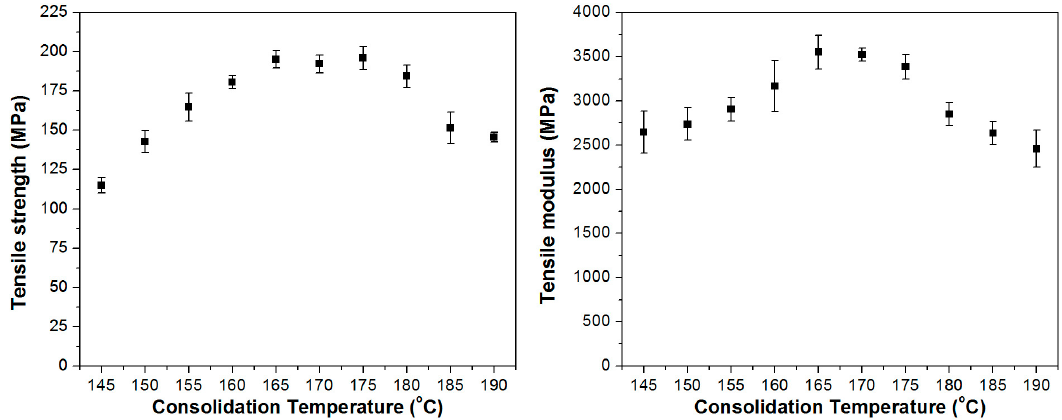
Figure 5. Tensile strength and modulus of the UD SRCs prepared at different consolidation temperatures.